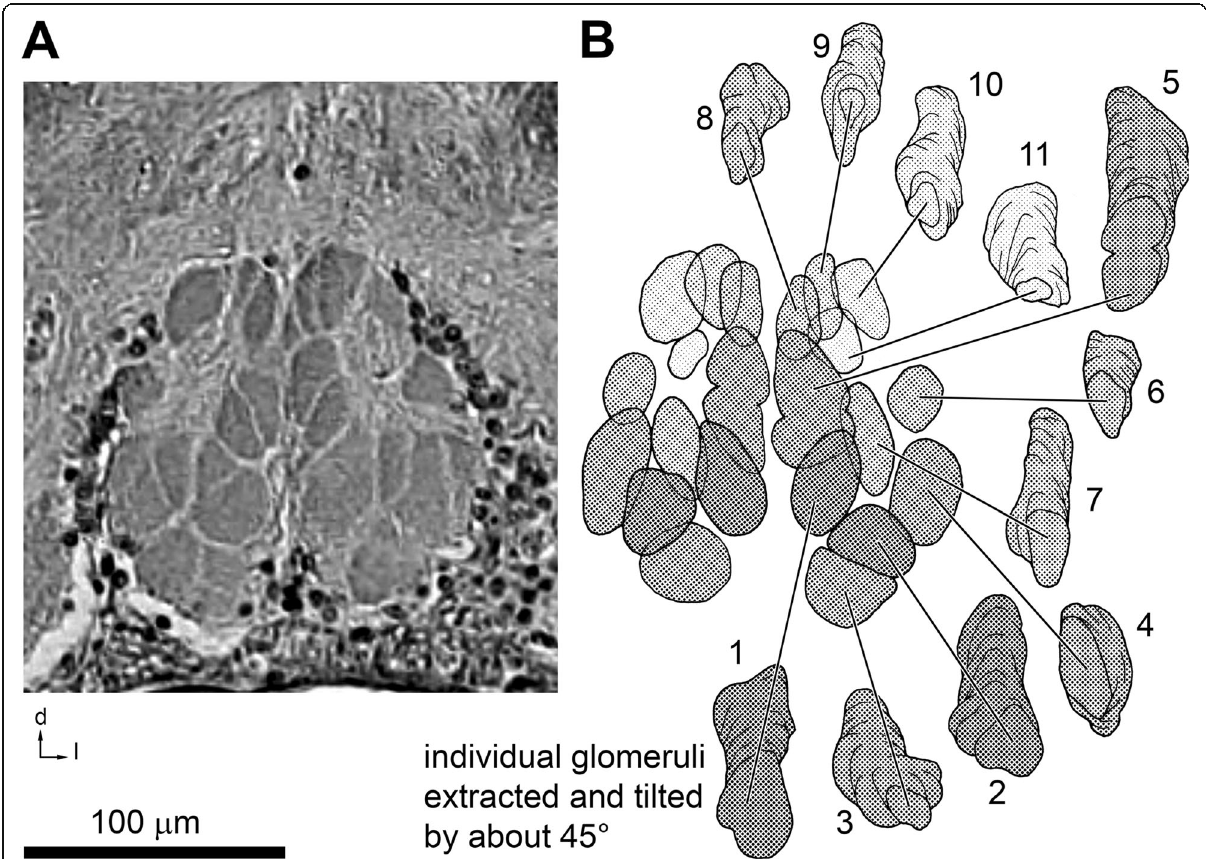
Fig. 6 Glomerular organization of the malleolar neuropil, detail. a Transversal section through the anterior and ventralmost neuropil of the synganglion in Galeodes turkestanus (paraffin histology). Glomerular structures are clearly discernible in the compact malleolar neuropil, surrounded ventrally and laterally by somata, and dorsally and more laterally by neuropil of the pedipalpal neuromere. Ventrally, this histological section is delimited by the ganglion surface. b Schematic representation of individual glomeruli of the malleolar neuropil, frontal view. Glomeruli are shown as maximum projections along the longitudinal body axis, and thus partly appear to overlap due to their skewed arrangement (compare Figs. 3c and 4). More anterior and more posterior glomeruli are indicated in darker and lighter shadings, respectively. An exploded view of the glomerulus arrangement surrounds the neuropil reconstruction. Positions of the individual glomeruli are indicated by lines emerging from the frontal view. Numbering corresponds to Fig. 5b. The reconstructed glomeruli are tilted by about 45°, posterior end up, to illustrate their shapes and approximate sizes. Histological section planes (10 μ m) are indicated by contour lines. For all images, dorsal is to the top and lateral to the